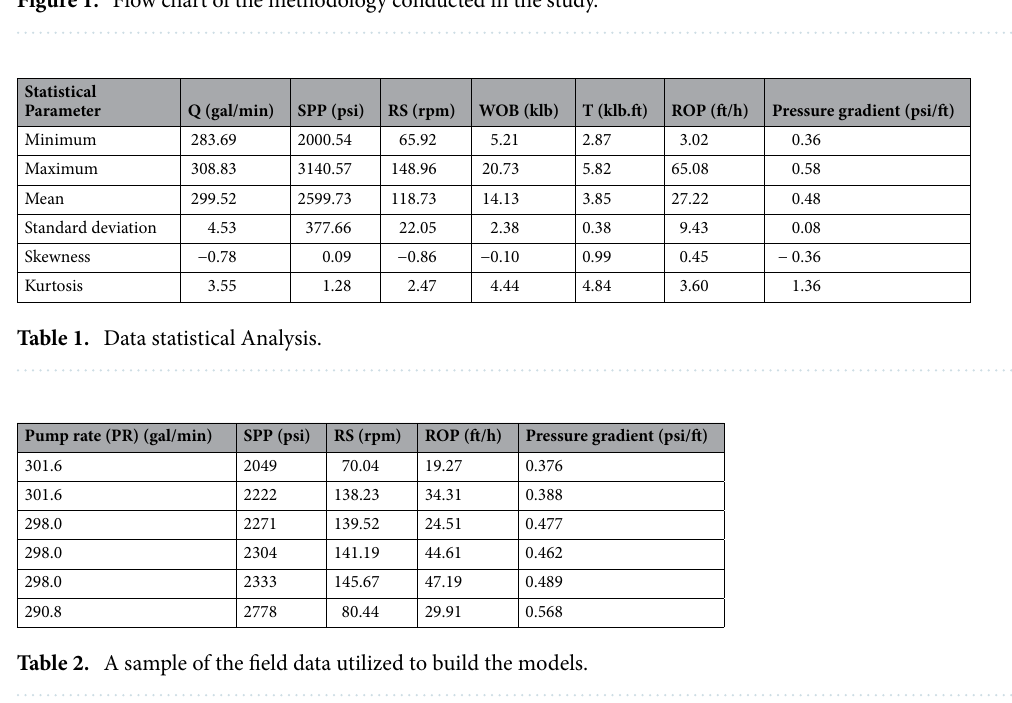
Table 2. A sample of the field data utilized to build the models.